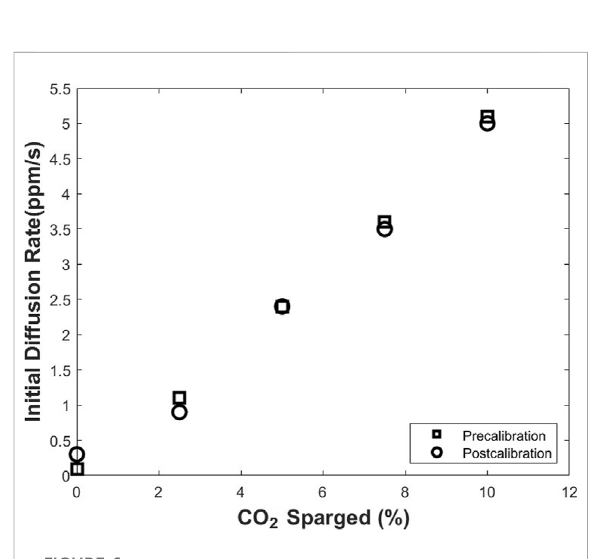
Pre- and post-calibration of the CO 2 monitoring device before and after a 7-days cell culture. The comparison between the two data sets indicates no signi fi cant biofouling throughout the cell culture